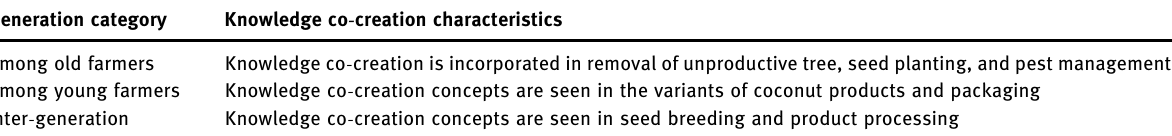
Table 2: Knowledge co - creation between old farmers and young farmers in coconut agribusiness Generation